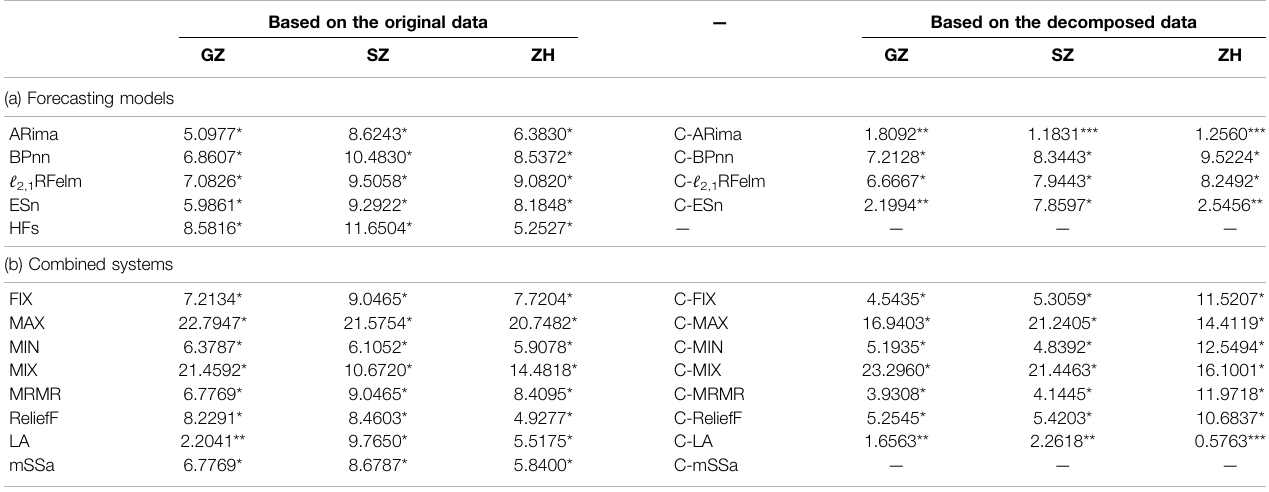
TABLE 7 | DM test results of different models. Based on the original data — Based on the decomposed data GZ SZ ZH